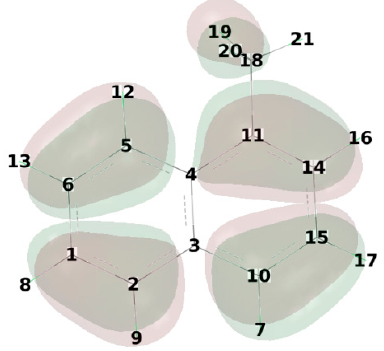
Figure 2. Isosurface of HOMO of 1-methylnaphthalene molecule.